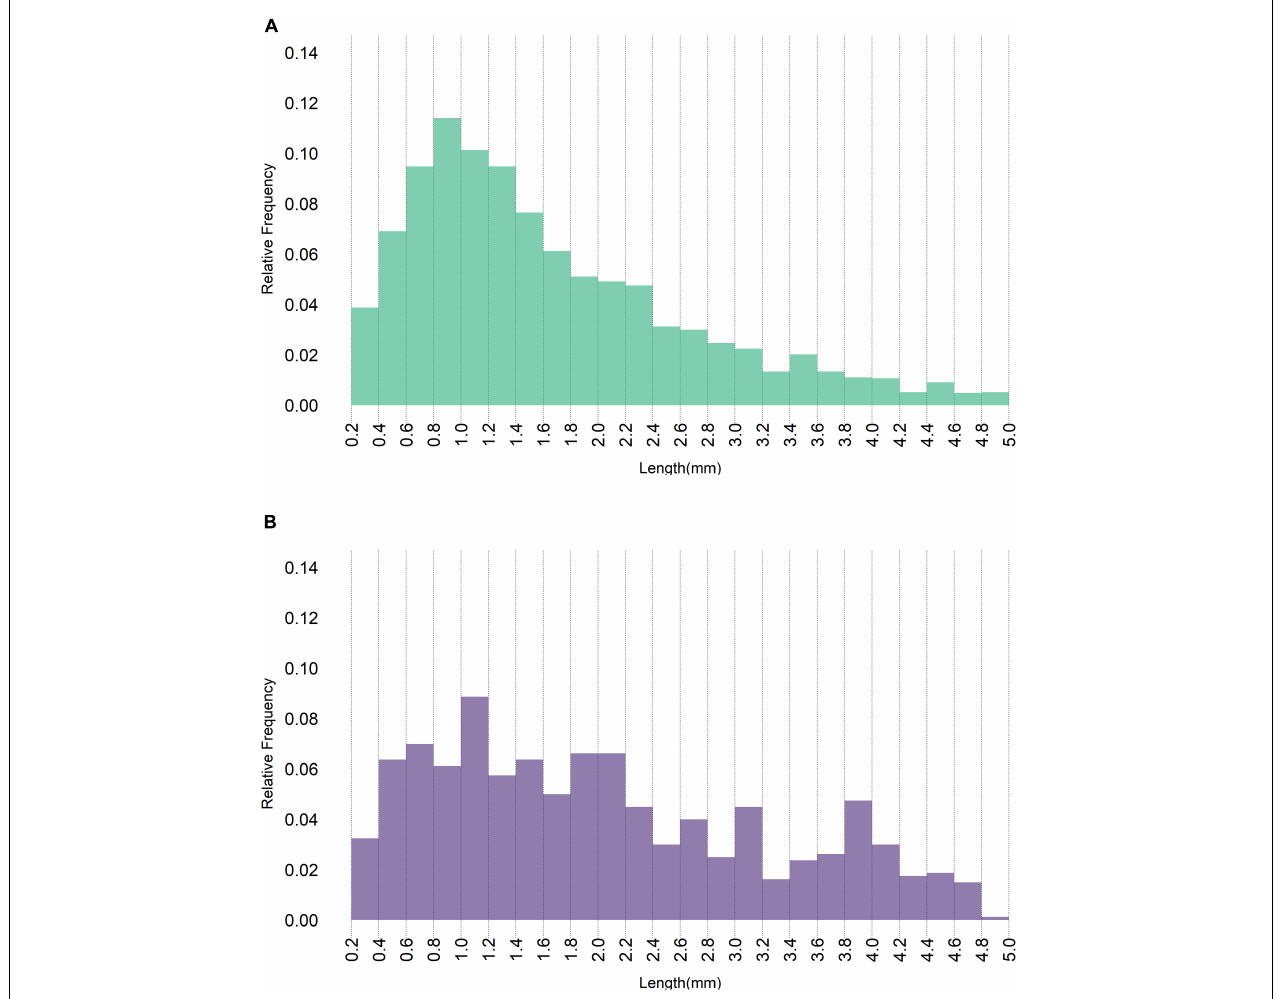
FIGURE 5 | Histograms of the relative frequency of the MPs length (mm) for MPs collected in the Ionian, Aegean and Levantine Sea (Open Sea) (A) and in the inner Saronikos Gulf (B)